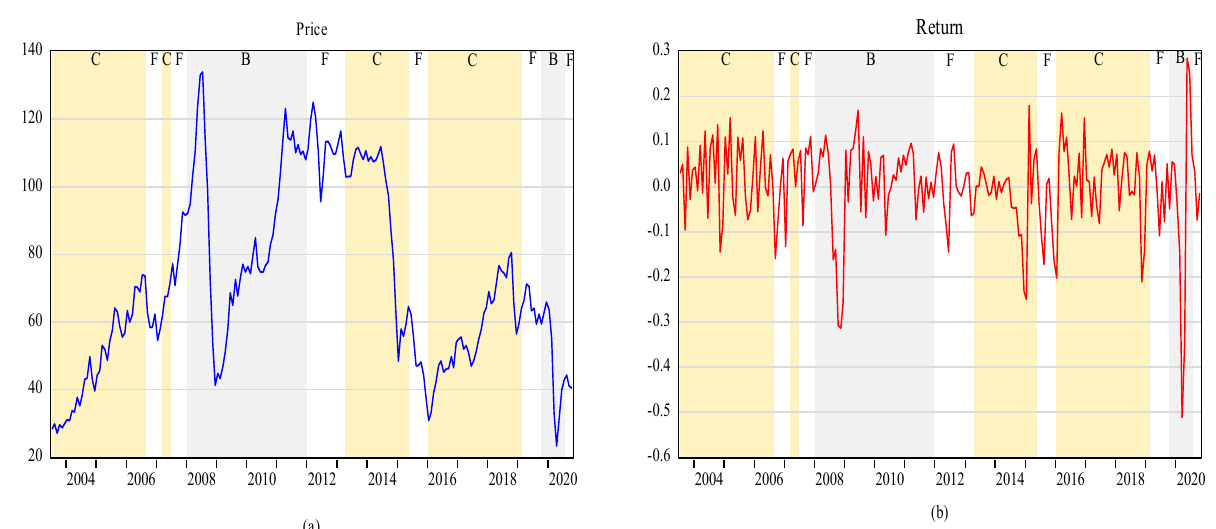
Figure 4. Evolutionary characteristics of prices and returns for the international crude oil market with different attributes’ periods. Notes: ( a ) refers to the evolution of spot prices in the international crude oil market, and ( b ) is the evolution of returns for the international oil market. B is dominated by both financial attribute and commercial attribute, C is dominated by commercial attribute, and F is a financial attribute of oil.